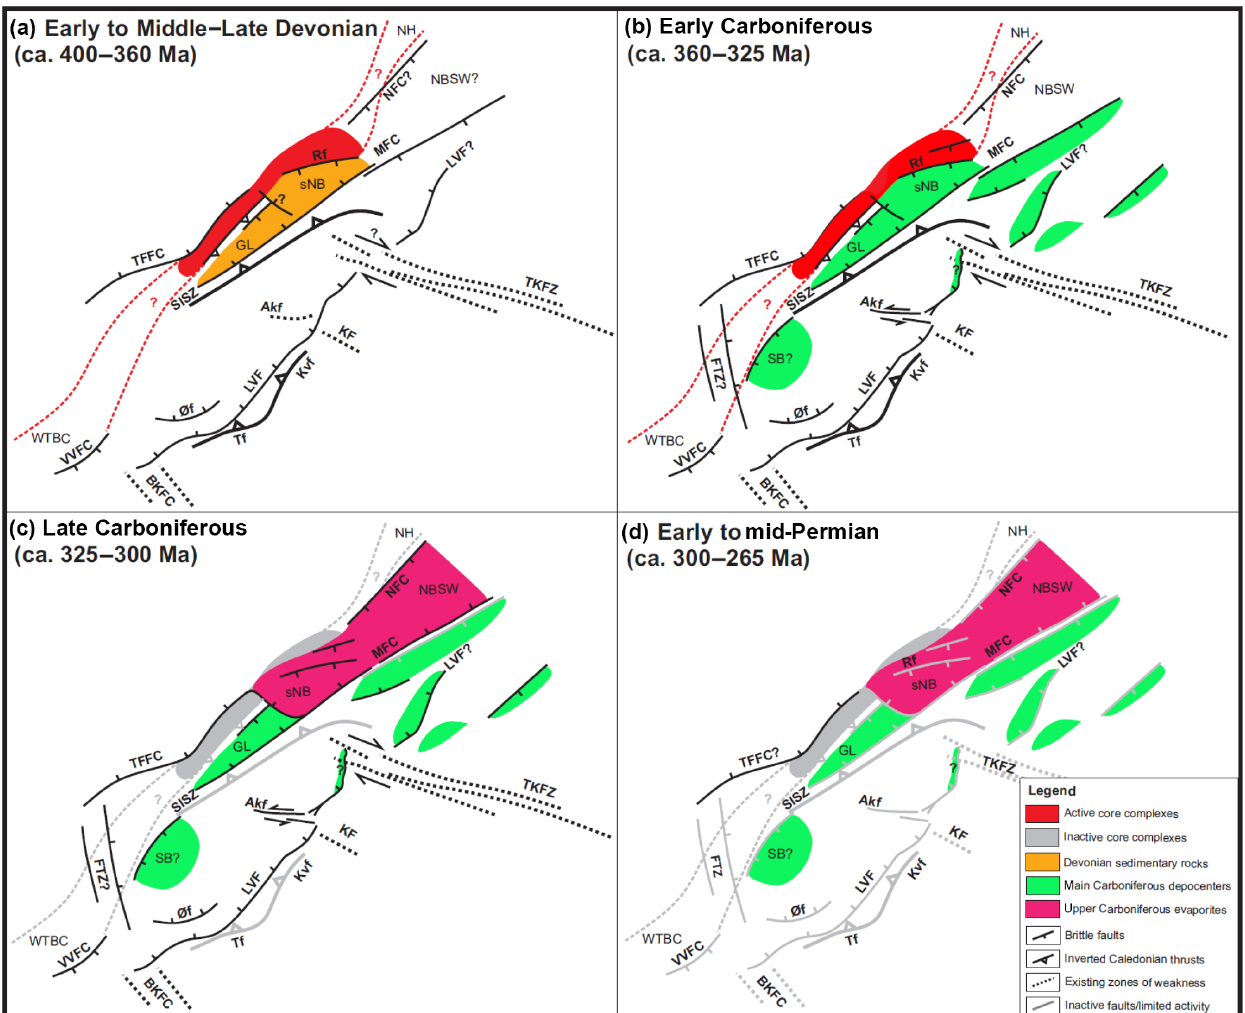
Figure 11. Map-view figures summarizing the late Paleozoic tectono-sedimentary evolution of the Finnmark Platform and southwesternmost Nordkapp basin (sNB). The tectonic evolution of onshore and nearshore faults in NW Finnmark is from Koehl et al. (2018). Abbreviations as in Fig. 1. (a) In the Early to Middle–Late Devonian, major Caledonian thrusts (e.g., SISZ) were inverted as low-angle extensional shear zones and exhumed metamorphic core complexes in the footwall of the TFFC and of the Rolvsøya fault. Thick Devonian sedimentary rocks were deposited within a spoon-shaped trough created by the geometry of the SISZ; (b) core complex exhumation continued through the early Carboniferous, though mostly accommodated by high-angle normal faults, which formed as brittle splays along Caledonian thrusts and shear zones (e.g., MFC, TFFC, Rolvsøya fault, and LVF). Core complex exhumation ceased by the end of the Serpukhovian and the WNW–ESE-trending segment of the TFFC formed as an accommodation cross fault that decoupled the western Finnmark Platform from the southwesternmost Nordkapp basin, thus contributing to the preservation of thick Devonian and lower Carboniferous sedimentary successions in the southwesternmost Nordkapp basin while these sedimentary rocks were almost completely eroded on the western Finnmark Platform. Minor graben and half-graben structures formed on the eastern Finnmark Platform. Precambrian WNW–ESE- to NNW–SSE-trending fault zones such as the TKFZ segmented the margin and acted as minor transfer faults that accommodated a limited amount of lateral displacement. Faulting along these faults ceased in the early Carboniferous; (c) in the late Carboniferous, inverted Caledonian thrusts and shear zones became inactive and were truncated by high-angle splay faults that accommodated the deposition of syn-tectonic sedimentary wedges on the eastern and western Finnmark Platform, and of thick, partly evaporitic deposits in the southwesternmost Nordkapp basin; (d) by the end of the Carboniferous, active brittle faulting came to a halt and the Finnmark Platform and the southwesternmost Nordkapp basin are believed to have remained tectonically